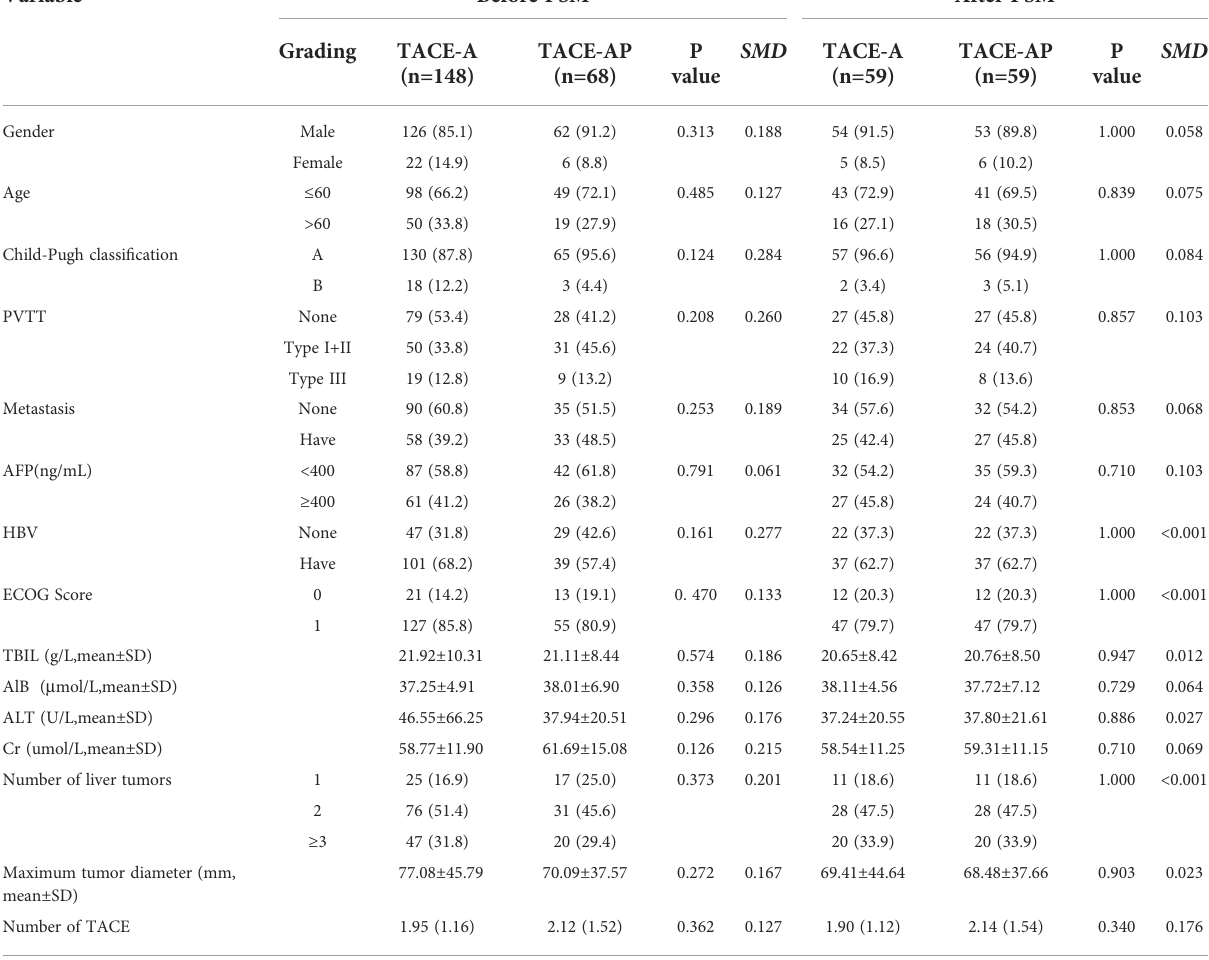
TABLE 1 Baseline characteristics of the two groups before and after PSM. Variable Before PSM After